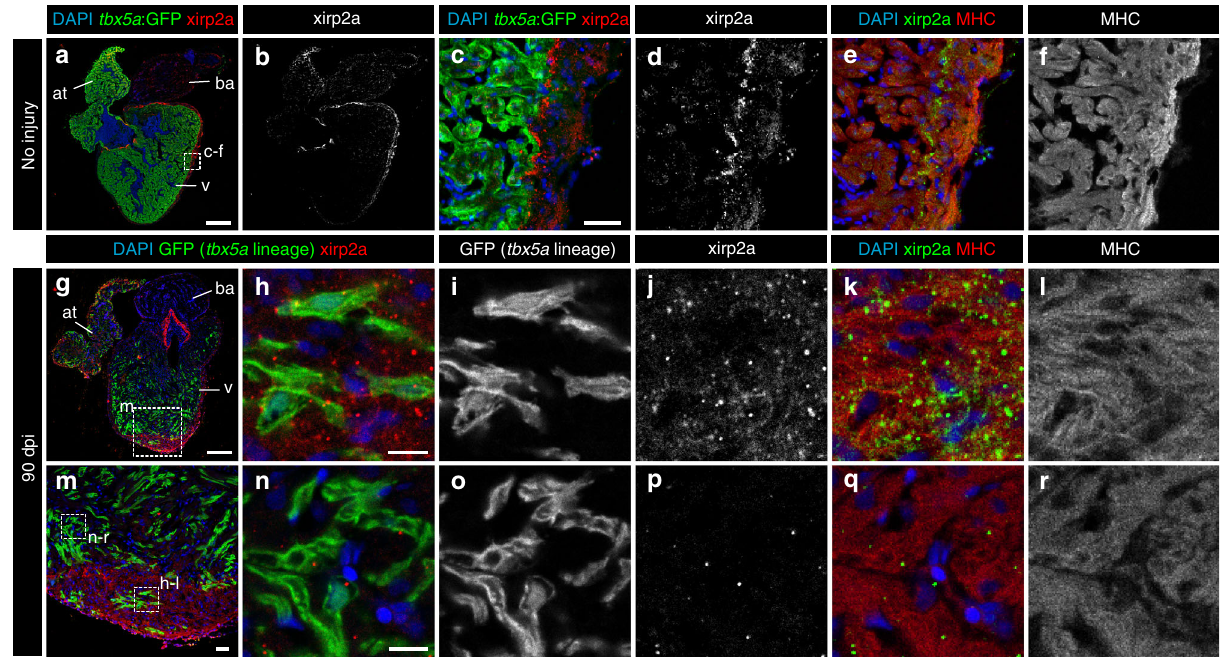
Fig. 8 Trabecular tbx5a -derived cardiomyocytes within the cortical myocardium express the cortical marker Xirp2a. Immuno fl uorescence with anti-Xirp2a and GFP and anti-Myosin Heavy Chain (MHC) on ventricle sections. a – f Uninjured adult tbx5a : GFP ventricle. Xirp2a expression was observed in the cortical layer but not in the trabecular layer showing a complementary pattern with tbx5a:GFP as predicted by the RNA-Seq ( n = 3/3). g – r Double transgenic tbx5a : mCherry-p2a-CreER T2 ; ubb : loxP-lacZ-loxP-GFP were treated with 4-Hydroxytamoxifen (4-OHT) from 84 to 72 and 60 to 48 hours before cryoinjury. Hearts were fi xed at 90 days postinjury (dpi). GFP + cells marking the tbx5a lineage within the cortical layer were positive for Xirp2a, whereas GFP + cells within the trabecular layer did not express this marker ( n = 6/6). at, atrium; ba, bulbus arteriosus; v, ventricle. Scale bars, a , g 100 µ m, c , m 25 μ m, and h , n 10 µ